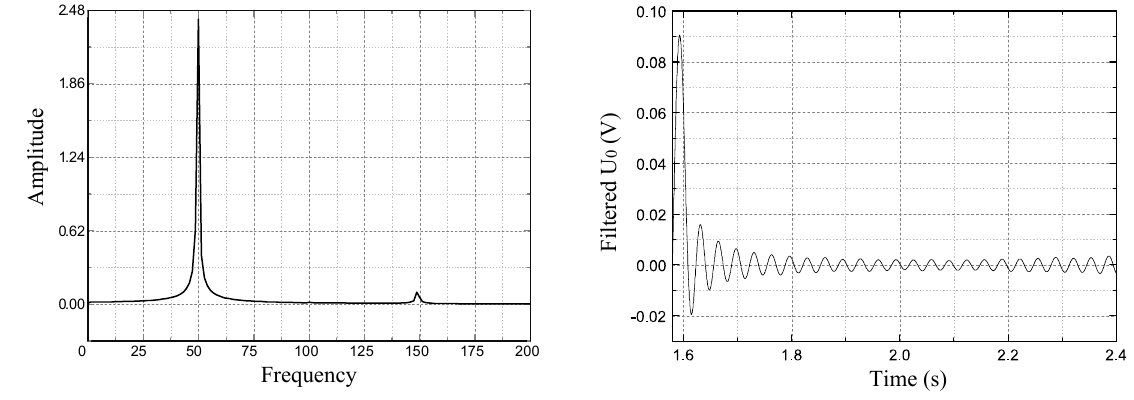
Figure 11. Zero-sequence voltage analysis result when R = ∞.